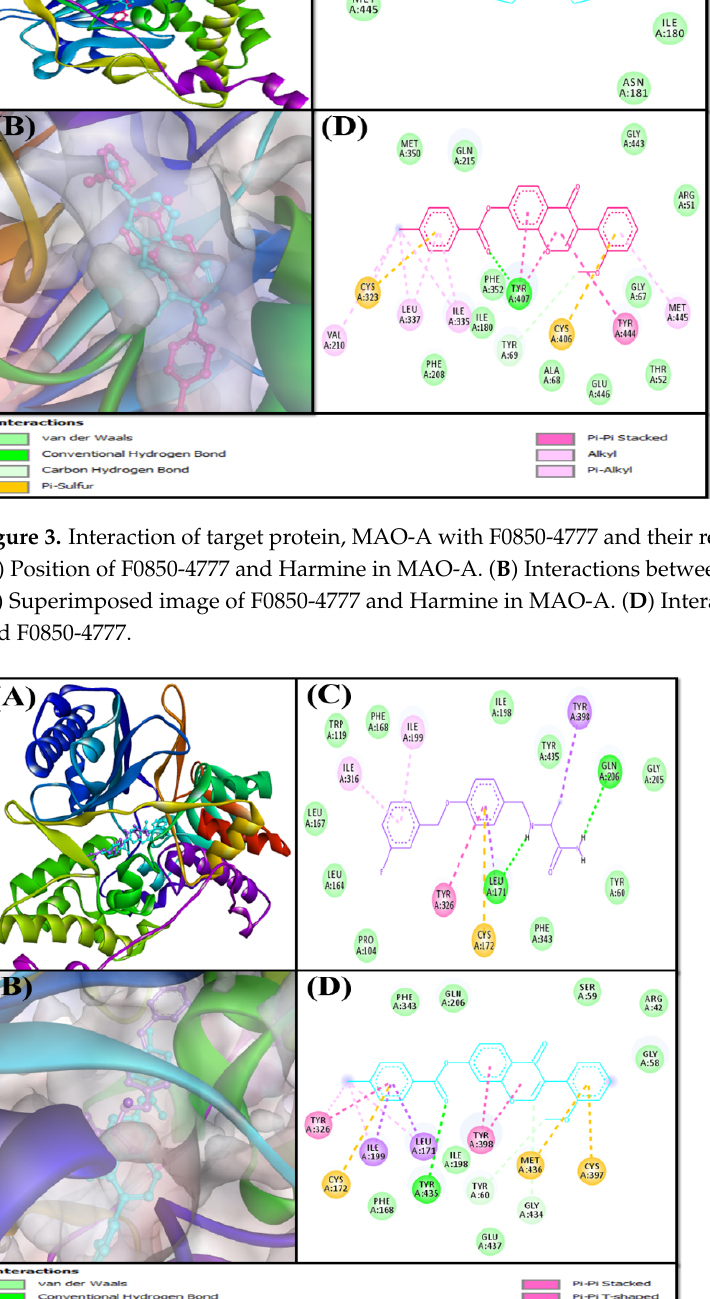
Figure 4. Interaction of target protein, MAO-B with F0850-4777 and their respective control ligands. ( A ) Position of F0850-4777 and Safinamide in MAO-B. ( B ) Interactions between MAO-B and Safinamide. ( C ) Superimposed image of F0850-4777 and Safinamide in MAO-B. ( D ) Interactions between MAO-B and F0850-4777.